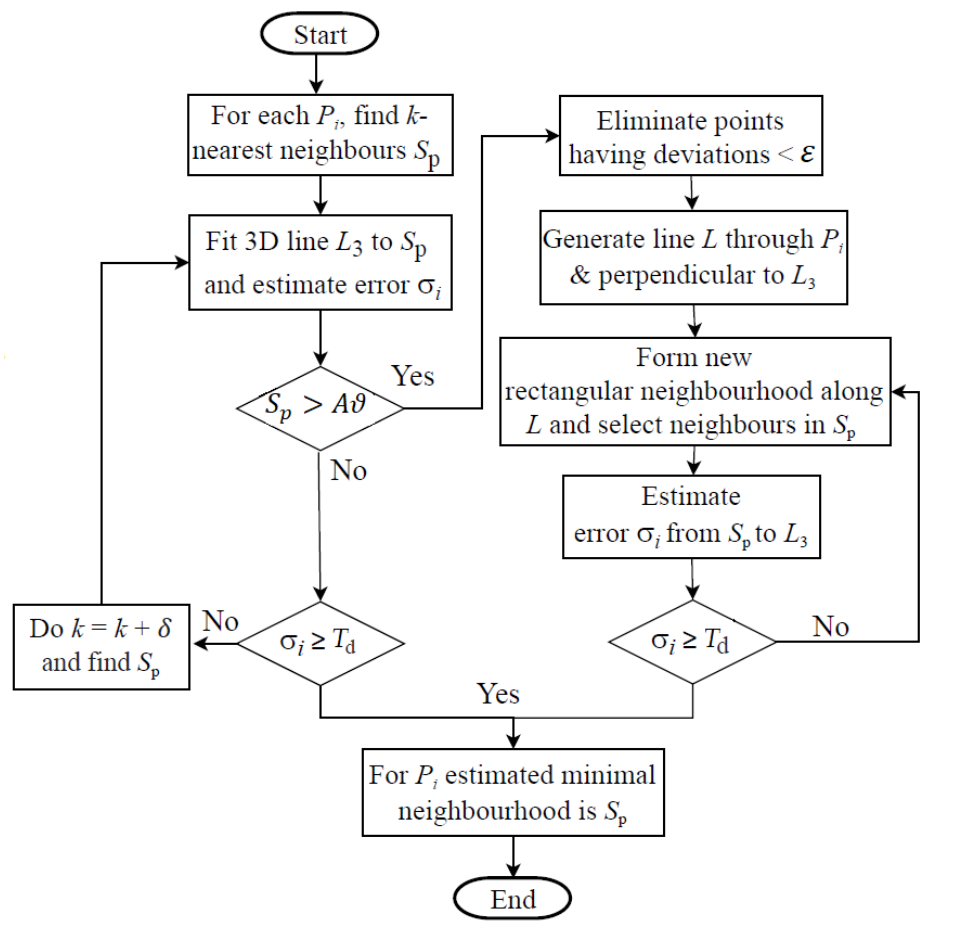
Figure 2. The workflow of the proposed variable neighbourhood selection method: T d is the threshold, σ i is the standard deviation, ε is the distance error, and δ is the neighbourhood